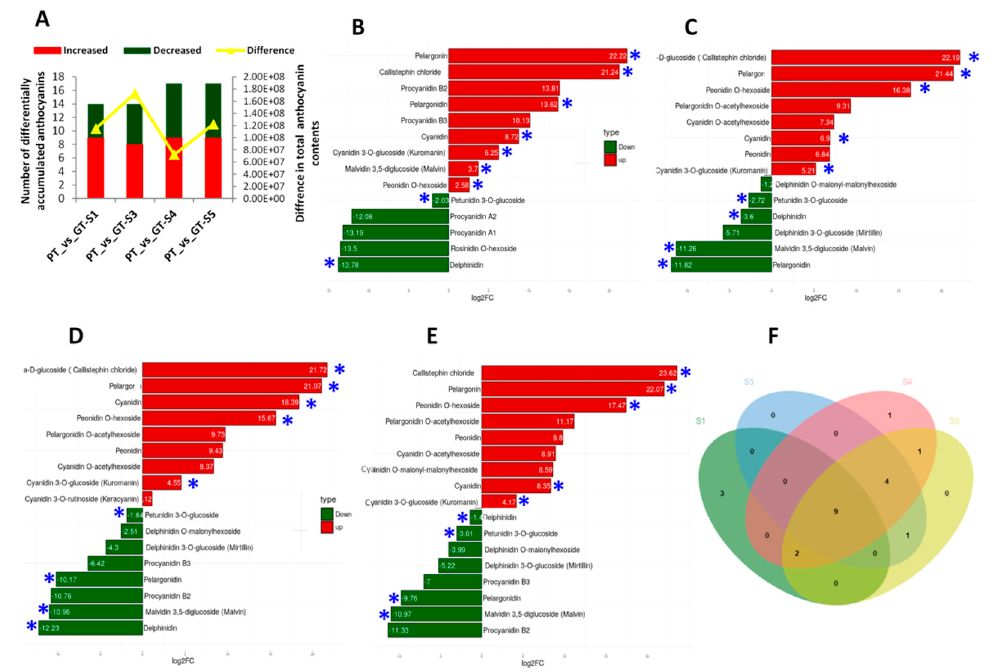
Figure 4. Temporal changes of anthocyanin content in two turnips. ( A ) Number of increased and decreased anthocyanins between PT and GT at different developmental stages S1–S5. The yellow line shows the difference in total anthocyanin content between PT and GT. PT represents the purple turnip while GT represents the green turnip; ( B–E ) differentially accumulated anthocyanins at S1, S3, S4, and S5 and their log2 fold change values between PT and GT. The asterisks mark the metabolites constantly differentially accumulated at the 4 developmental stages between PT and GT. ( F ) Venn diagram depicting the number of shared and unique differential accumulated anthocyanins between PT and GT at the 4 developmental stages.